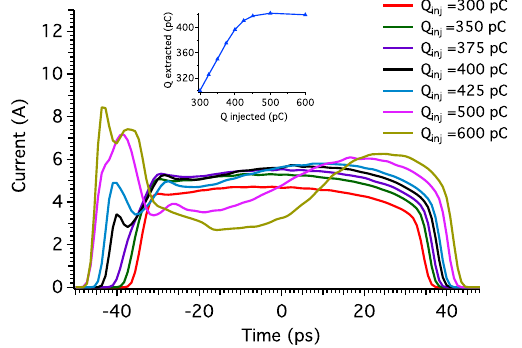
FIG. 4 (color online). Electron beam current extracted as function of charge injected (laser energy) into the diode. The example corresponds to the radius of 500 μ m in Fig. 2(a). The inset shows the extracted charge vs the injected one. The laser pulse length was fixed to 60 ps. The ASTRA code was used in the simulations.